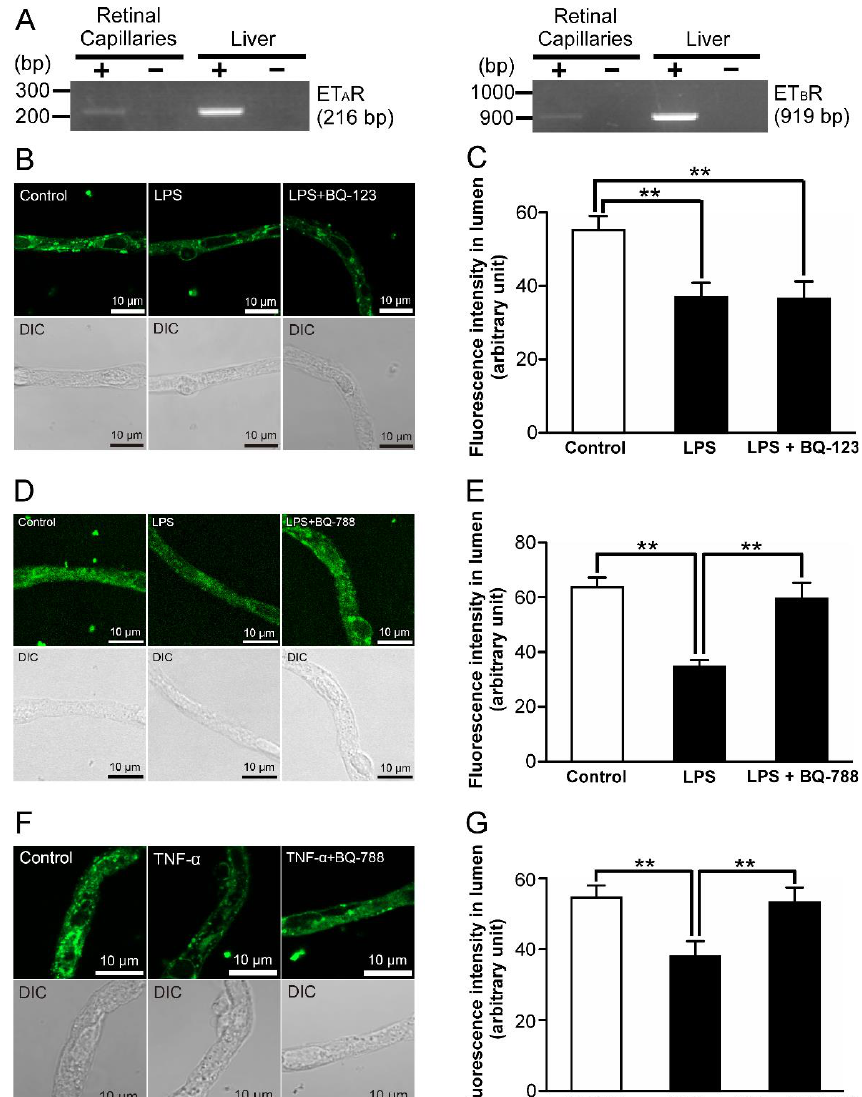
Figure 6. ET B receptor-mediated P-gp attenuation in the retinal capillaries under LPS-treated condi- tions. ( A ) mRNA expression of ET A receptor or ET B receptor in rat retinal capillaries. RT-PCR analysis was performed in the presence (+) or absence ( − ) of reverse transcriptase using specific primers for ET A receptor or ET B receptor. The rat liver was used as the positive control. ( B , D , F ) Representative confocal images of isolated rat retinal capillaries after incubation with NBD-CSA at 4 µ M for 60 min. The capillaries were preincubated with 1 ng/mL LPS or 1 ng/mL TNF- α in the absence or presence of BQ-123 (ET A receptor antagonist) at 30 nM, or BQ-788 (ET B receptor antagonist) at 10 nM for 30 min. ( C , E , G ) Quantification of NBD-CSA fluorescence in the lumens of retinal capillaries. Each column represents the mean value for 10 capillaries from a single preparation; variability is given by S.D. bars. Units are expressed as arbitrary fluorescence (scale 0–255). ** p < 0.01, significantly different between the groups. Capillary images in ( D ) were captured using a TCS-SP5, and those in ( B , F ) were captured using a LSM